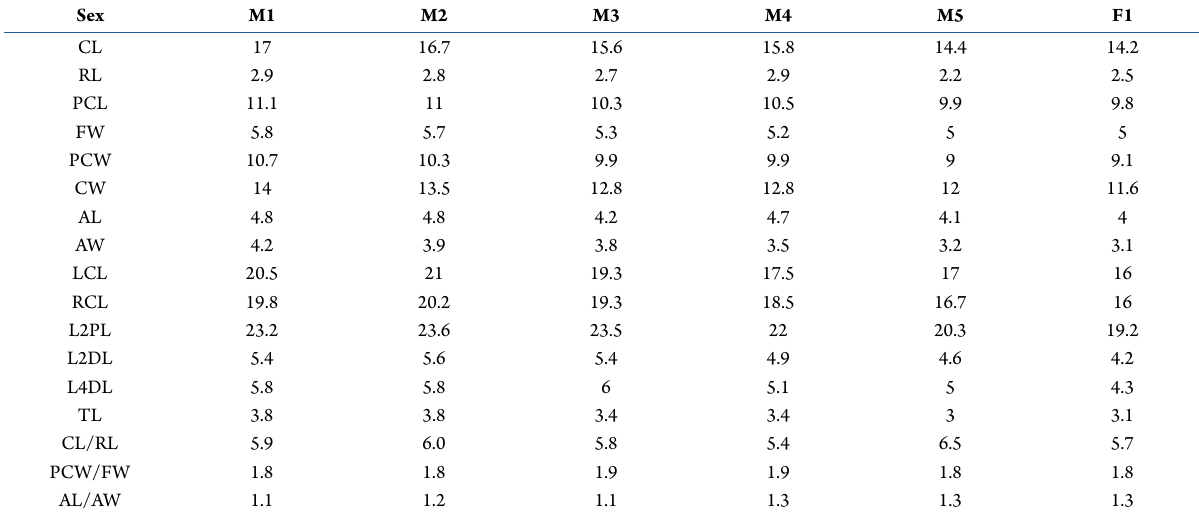
Table 2. Morphometry of Aegla chilota n. sp. additional examined material from a stream at 43º05’06” S, 73º43’07” W. Measurements in mm. M= male; F= female. Captions as in Table 1.